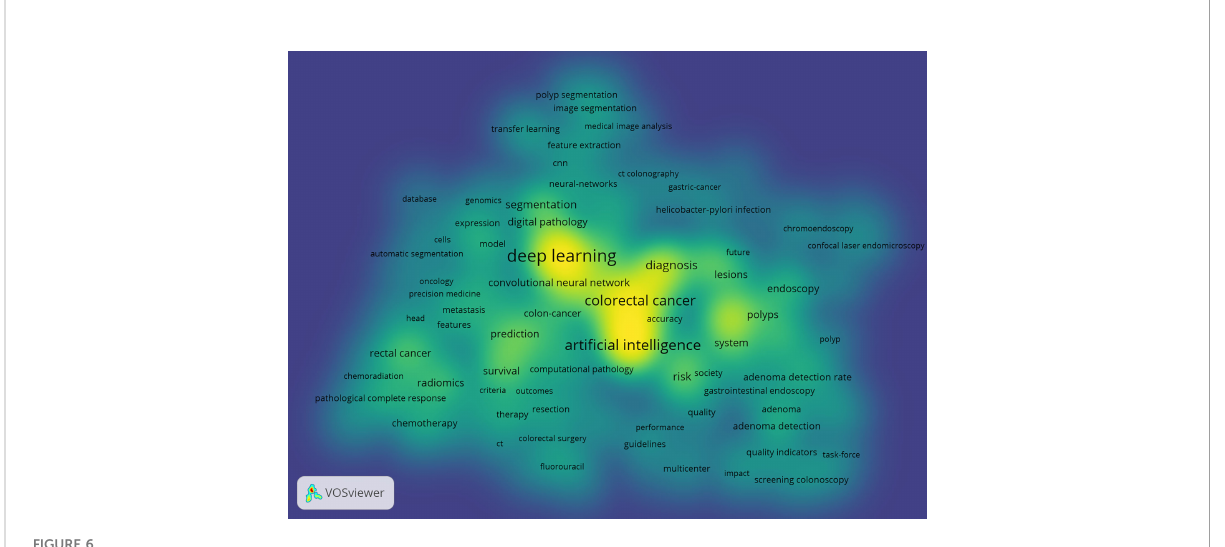
FIGURE 6 Density distribution of keywords